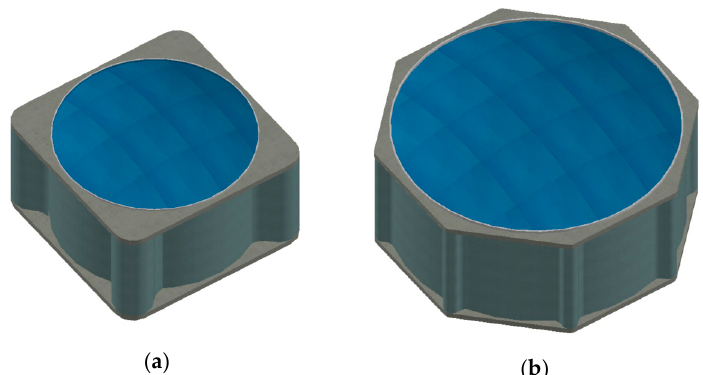
Figure 8. Isometric view of hydrocarbon storage tank: ( a ) small tank and ( b ) big tank.